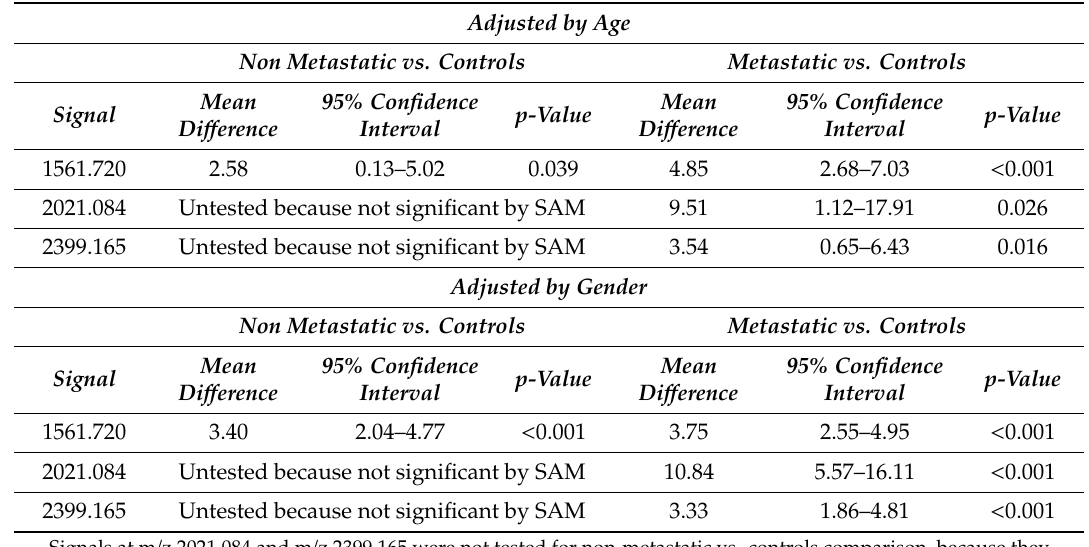
Table 4. Results from applying the multiple regression model to the peptides selected by the SAM analysis, adjusting by age and